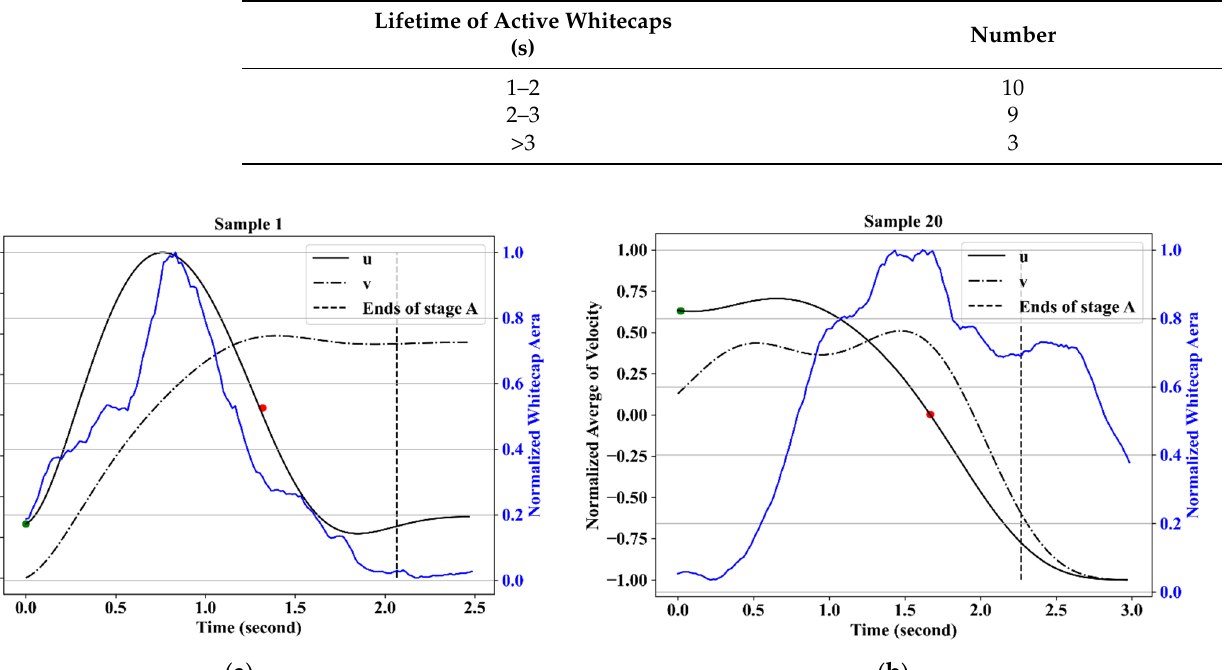
Table 1. Lifetime of active whitecaps in this study.